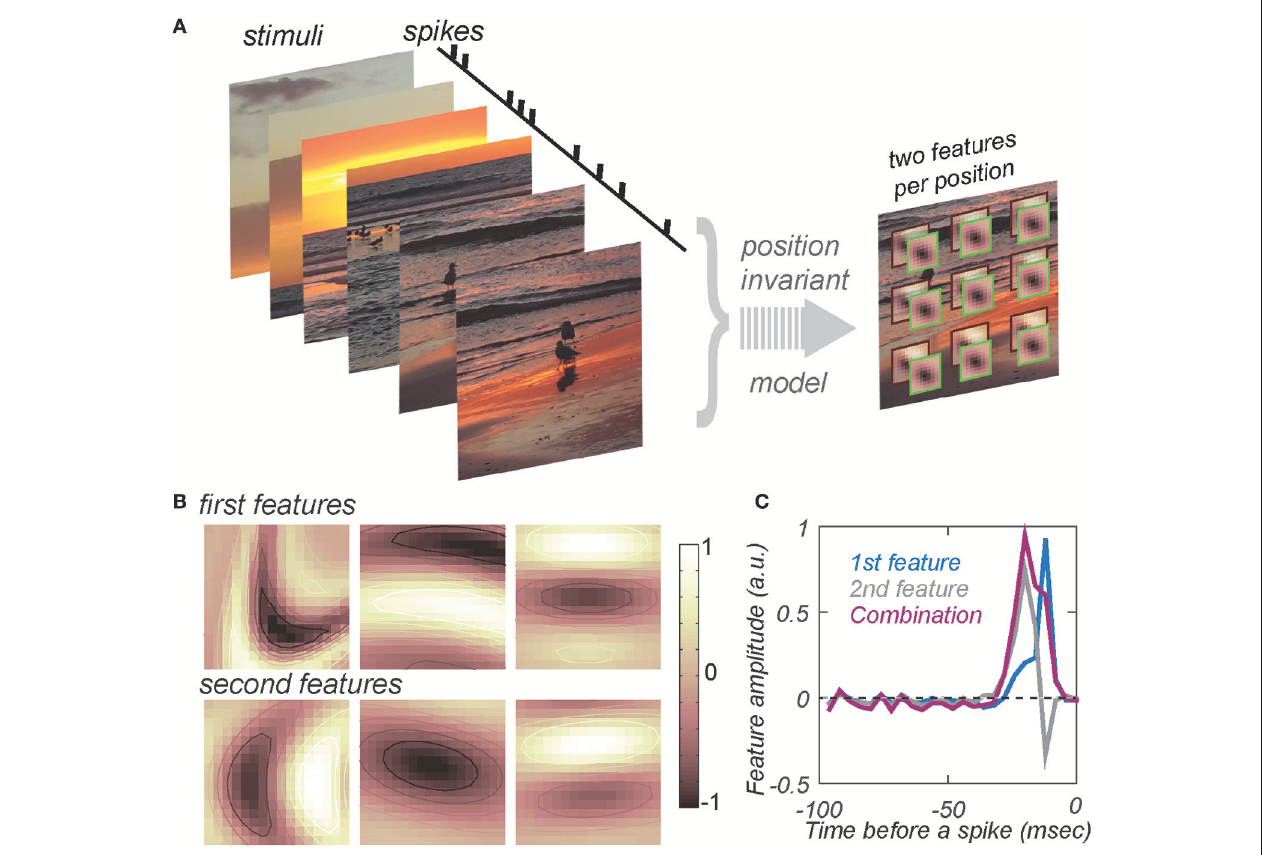
FIGURE 1 | Estimating feature selectivity and invariance properties from neural responses to natural stimuli. (A) Schematic of the model that combines position invariance with selectivity to conjunctions of two features at one position in the visual space. At each position in the visual space, stimuli are compared to the two features. The result of this computation produces two projection values, one for each feature. The two projection values are combined according to a nonlinear function (determined by fitting and not shown here). The results of this nonlinear computation at each position are combined according to a MAX (or logical OR) operation to obtain a prediction for the spike rate elicited by the stimulus. (B) Examples of the two most relevant image features for three V4 neurons from two different animals. Columns refer to different neurons, from left to right: m26a_3, j15c_1, j46a_1. The first and second rows show the first and second maximally informative feature per neuron, respectively. Each feature is shown after fitting by a curved Gabor model to the templates estimated from the responses of these neurons to natural stimuli (Sharpee et al., 2013). (C) A pair of two most relevant temporal profiles for an auditory neuron. Data are from field L (Sharpee et al., 2011a), a region analogous to the mammalian primary auditory cortex ( Sharpee et al., 2011a). The sum of the two relevant features (magenta) produces a time dilated version of the first feature (blue). Neuron